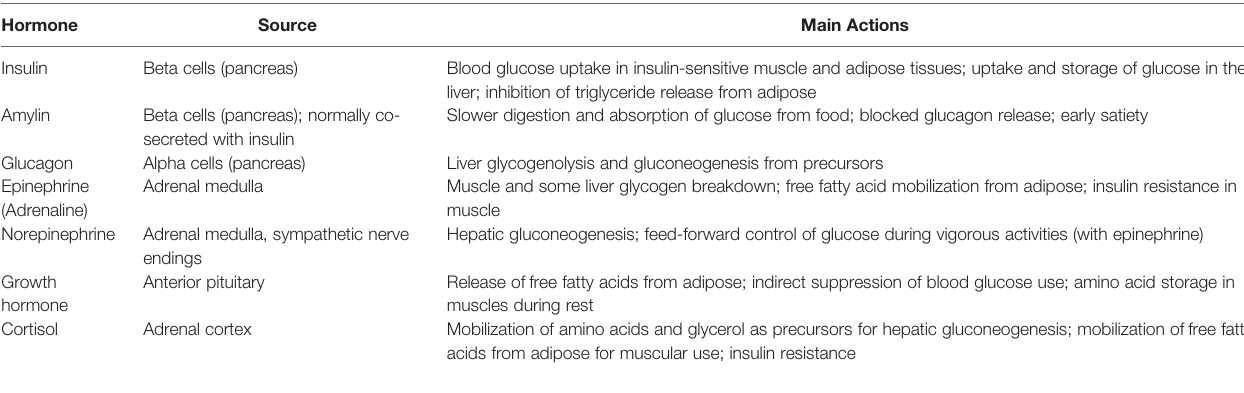
TABLE 1 | Counterregulatory hormones and Their Impact on Blood Glucose.